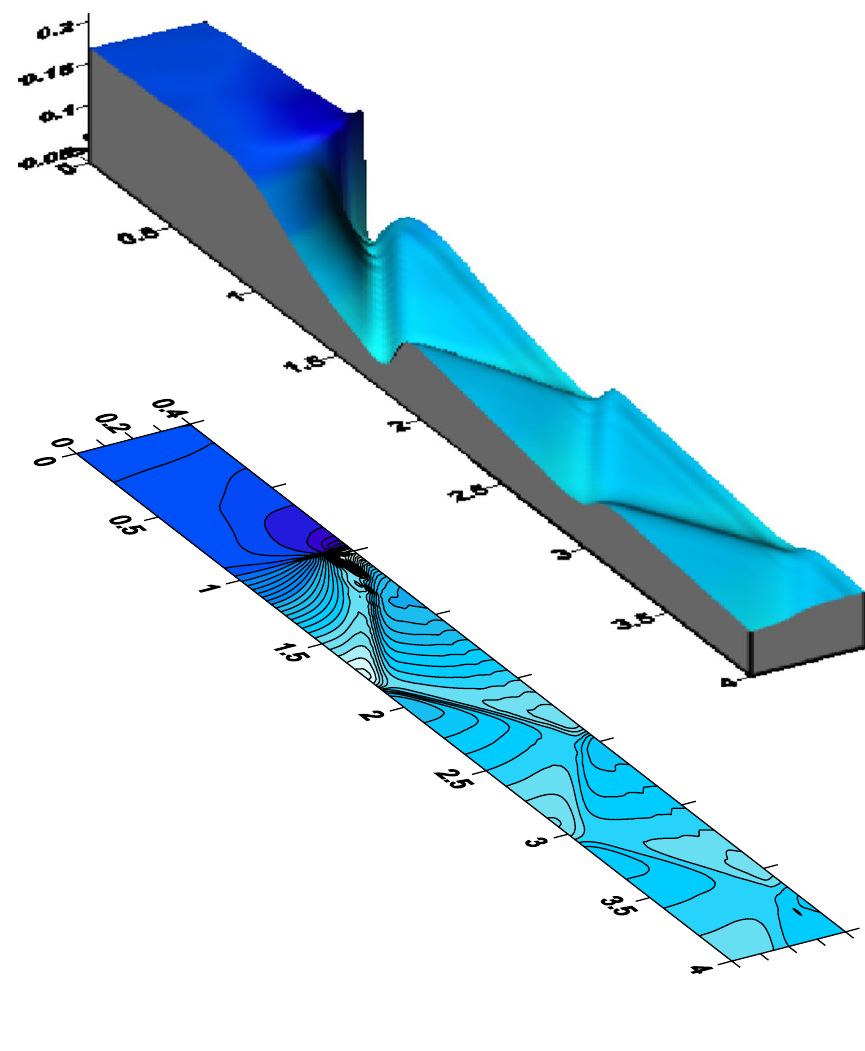
Fig. 3 The 3D view and counter lines of depths resulted from numerical experiments